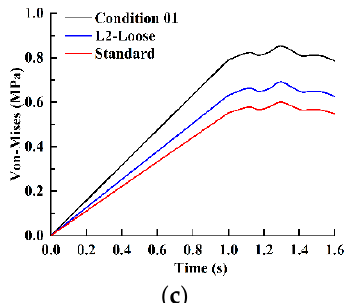
Figure 20. ( a ) The backfilling schematic of Condition 01; ( b ) the stress distribution of the pipe; ( c ) the time history curve of the right invert under Condition 01.